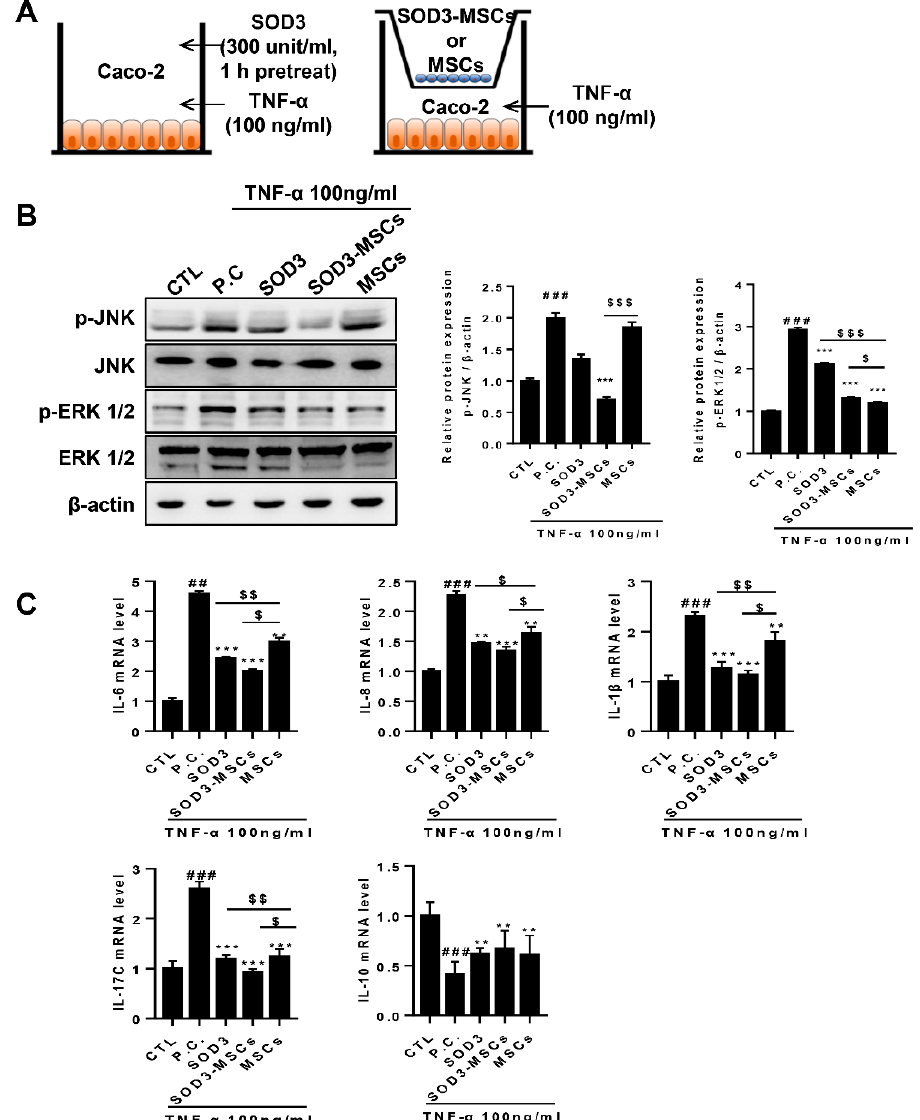
Figure 1. SOD3 and SOD3-MSCs inhibit the MAPK activation and inflammatory responses in response to TNF- α treatment. SOD3 (300 unit/mL) pretreatment or co-culture with SOD3-MSCs or MSCs were conducted to determine inflammatory activation of Caco-2 cells treated with TNF- α (100 ng/mL). ( A ) Schematic diagram of in vitro experiments. After harvesting Caco-2 cells, RNA or protein was extracted for further analysis. ( B ) The expression of p-JNK, JNK, p-ERK1/2, and ERK1/2 was determined by western blotting. ( C ) The expression of pro- (IL-6, IL-8, IL-1 β , IL-1 and IL-17C) or anti-inflammatory (IL-10) cytokines in mRNA level was determined by quantitative PCR. CTL: untreated control; P.C: TNF- α -treated positive control, ## p < 0.01, ### p < 0.001 (CTL vs. P.C), ** p < 0.01, *** p < 0.001 (P.C vs. SOD3, SOD3-MSC and MSCs), $ p < 0.05, $$ p < 0.01, $$$ p < 0.001 (SOD3, SOD3-MSCs vs. MSCs). Results are shown as mean ± SD. Results show one representative experiment of at least three independent